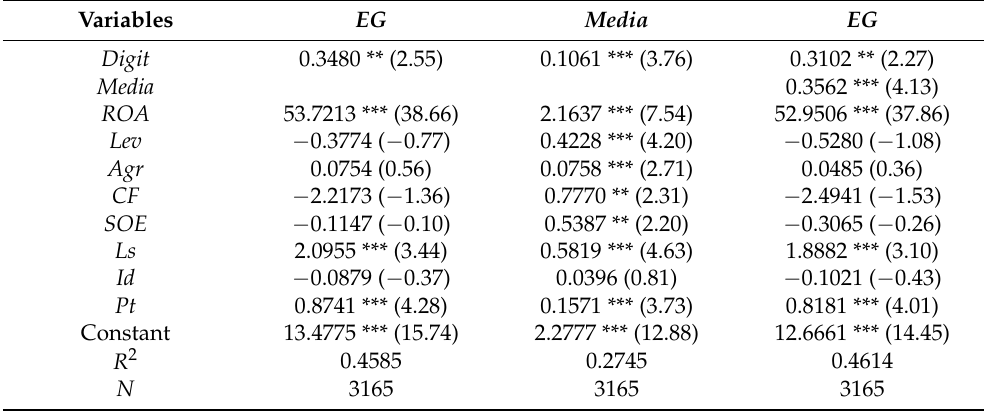
Table 9. Regression results of the media supervision channel